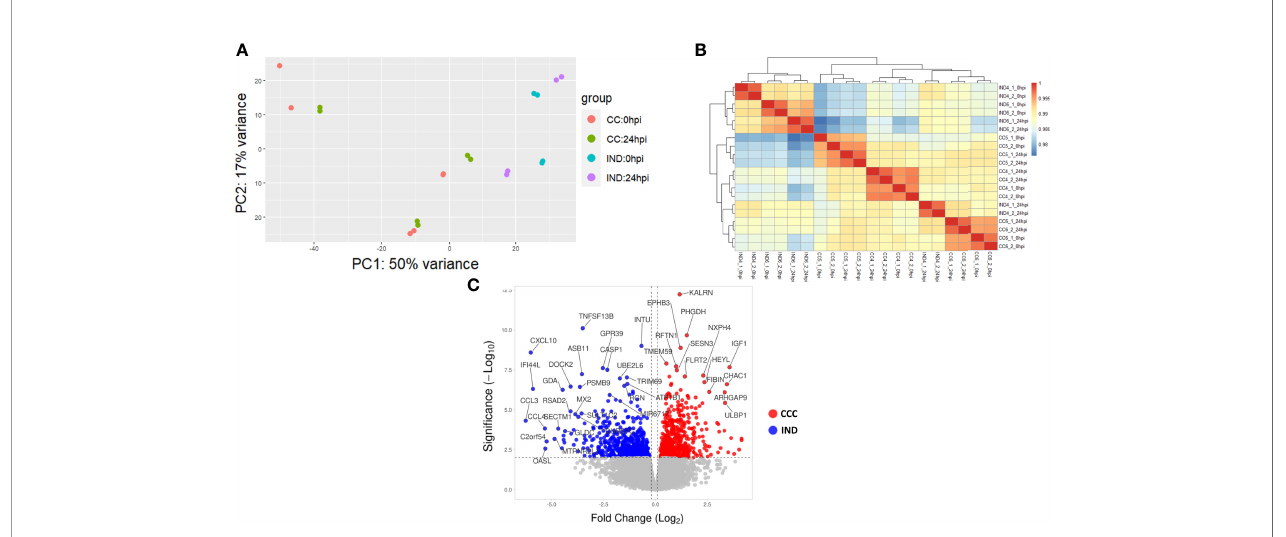
FIGURE 3 | RNA-seq results. (A) PCA plot showing the variability among CCC and IND replicates at 0 and 24 hpi (CCC replicates = 6 CCC_0hpi, 6 CCC_24hpi. IND replicates = 4 IND_0hpi and 4 IND_24hpi). (B) Hierarchical clustering of replicates. (C) Volcano plot showing the L2FC distribution of DEGs in the interaction term